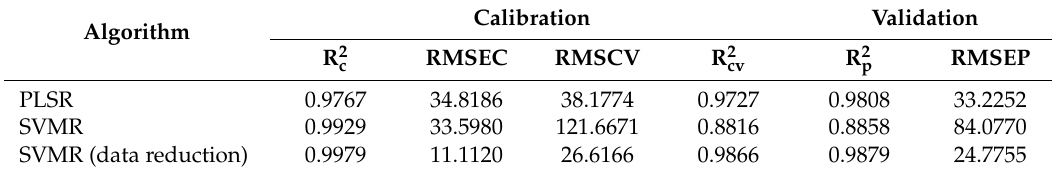
Table 3. The results for multivariate analysis for total samples with different modeling algorithms. Algorithm